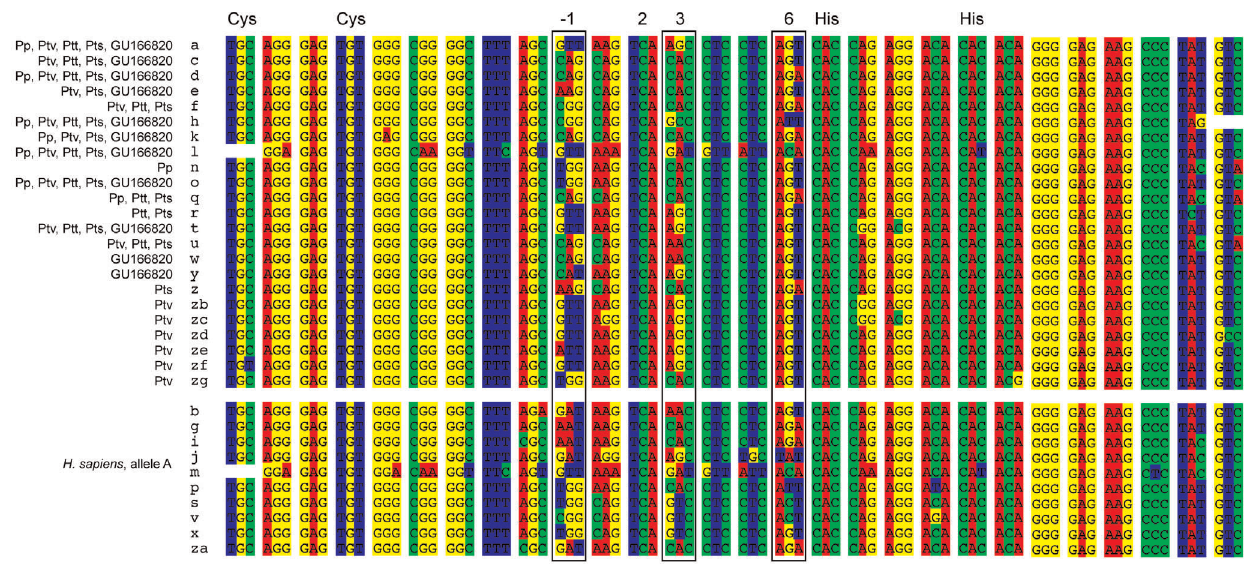
Figure 2. Alignment of PRDM9 ZnF repeats of 52 Pan individuals and one human. The ZnF repeats identified in 82 Pan alleles of which 28 are unique DNA sequences, including data from Auton et al. [36] and Oliver at al. (GU166820: [19]), are depicted in the top block. Pp = Pan paniscus, Ptv = P. troglodytes verus , Ptt = P. t. troglodytes , Pts = P. t. schweinfurthii . The second block depicts the ZnF repeats of the human A allele for comparison with those identified in Pan . For comparative purposes, we adhere to the break between repeats chosen by Oliver et al. [19]. The two conserved cysteine and histidine residues are marked at the top and positions 2 1, 3 and 6 of the alpha helices are identified by black frames.